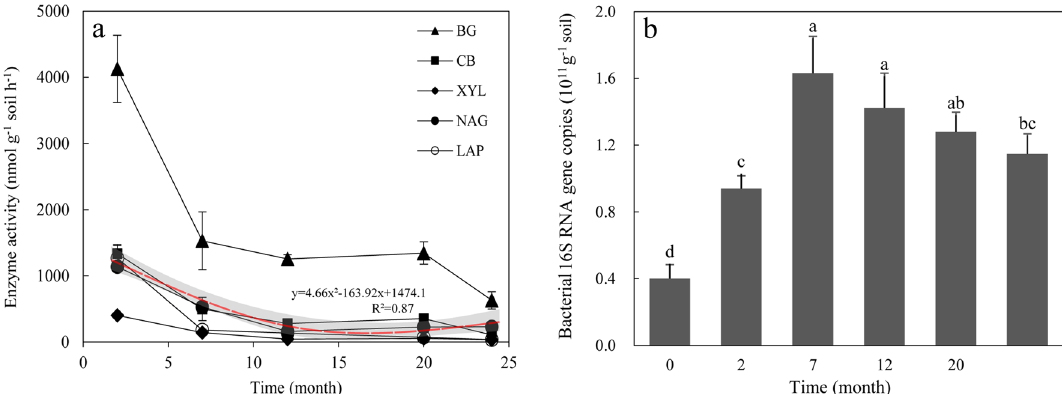
Figure 2. Changes in enzyme activity ( a ) and bacterial abundance ( b ) during straw decomposition. Different lower letters at the top of the columns present significant differences among decomposition periods (P < 0.05). BG, CB, XYL, NAG, and LAP are β-glucosidase, β-cellobiohydrolase, β-xylosidase, β- N -acetylglucosaminidase, and Leucine aminopeptidase activities, respectively.